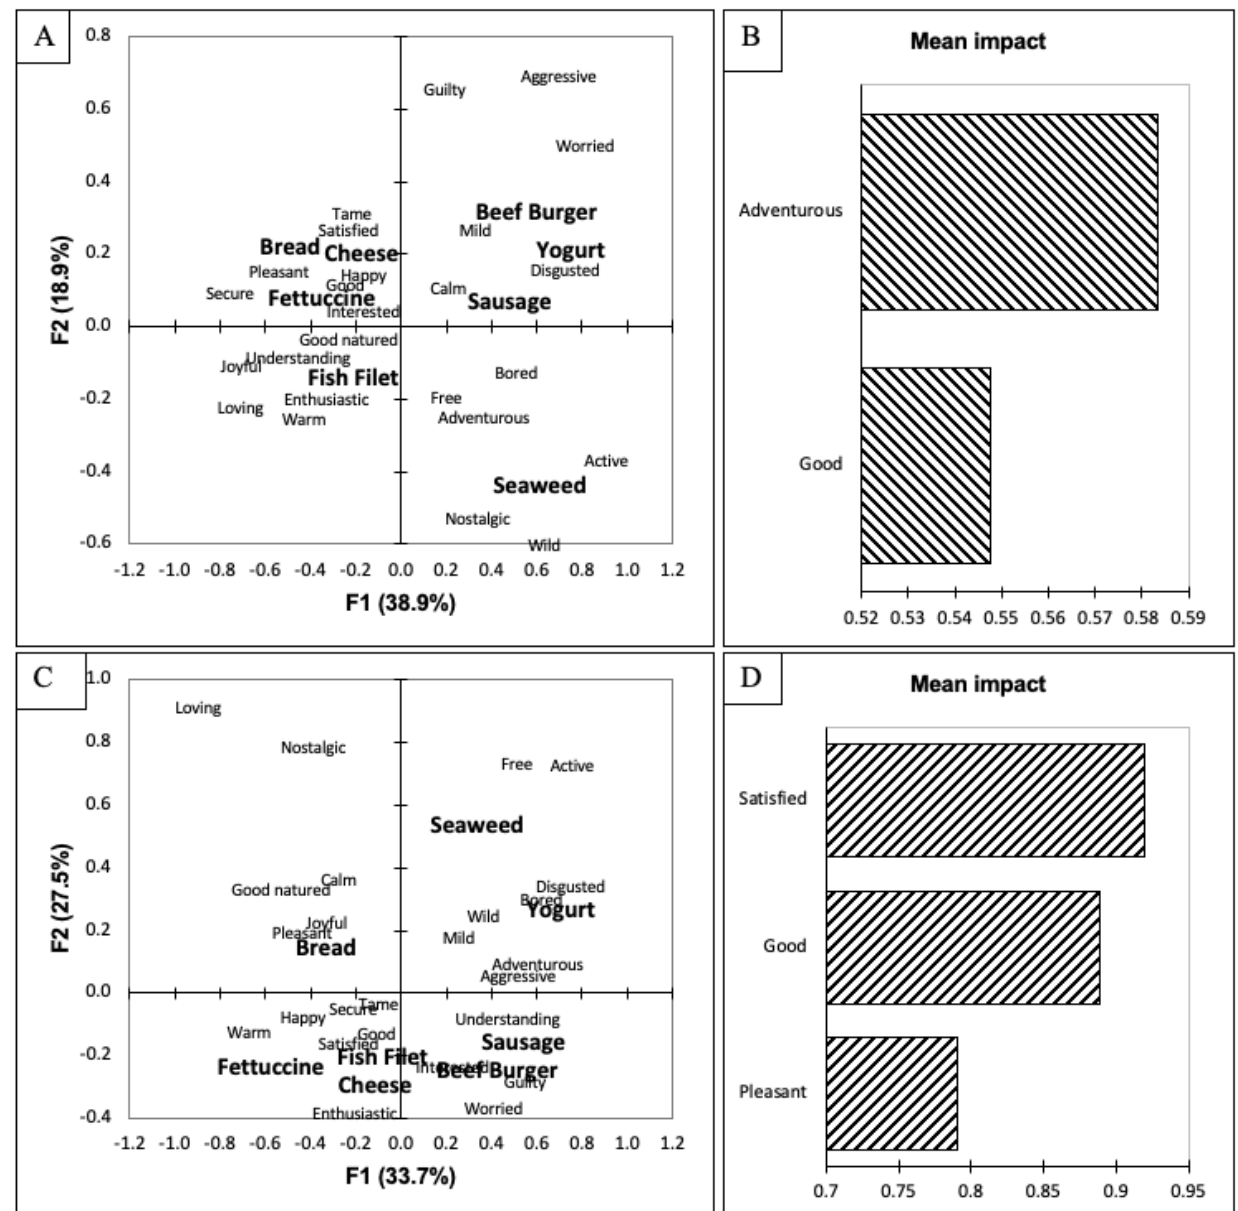
Figure 2. ( A ) Biplot representation of the seaweed-containing food items and emotional terms on the first two dimensions of the correspondence analysis for the population categorized as low hunger (LH). ( B ) Penalty lift analysis of the emotional terms and willingness to pay based on the LH population’s evaluation of the seaweed-containing food items. ( C ) Biplot representation of the seaweed-containing food items and emotional terms on the first two dimensions of the correspondence analysis for the population categorized as high hunger (HH). ( D ) Penalty lift analysis of the emotional terms and willingness to pay based on the HH population’s evaluation of the seaweed-containing food